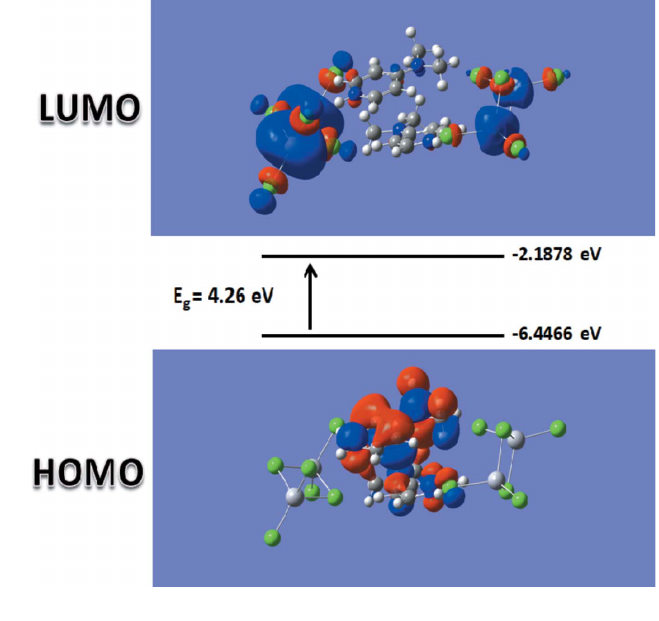
Figure 9 HOMO–LUMO molecular orbitals showing the ground to excited state electronic transitions for